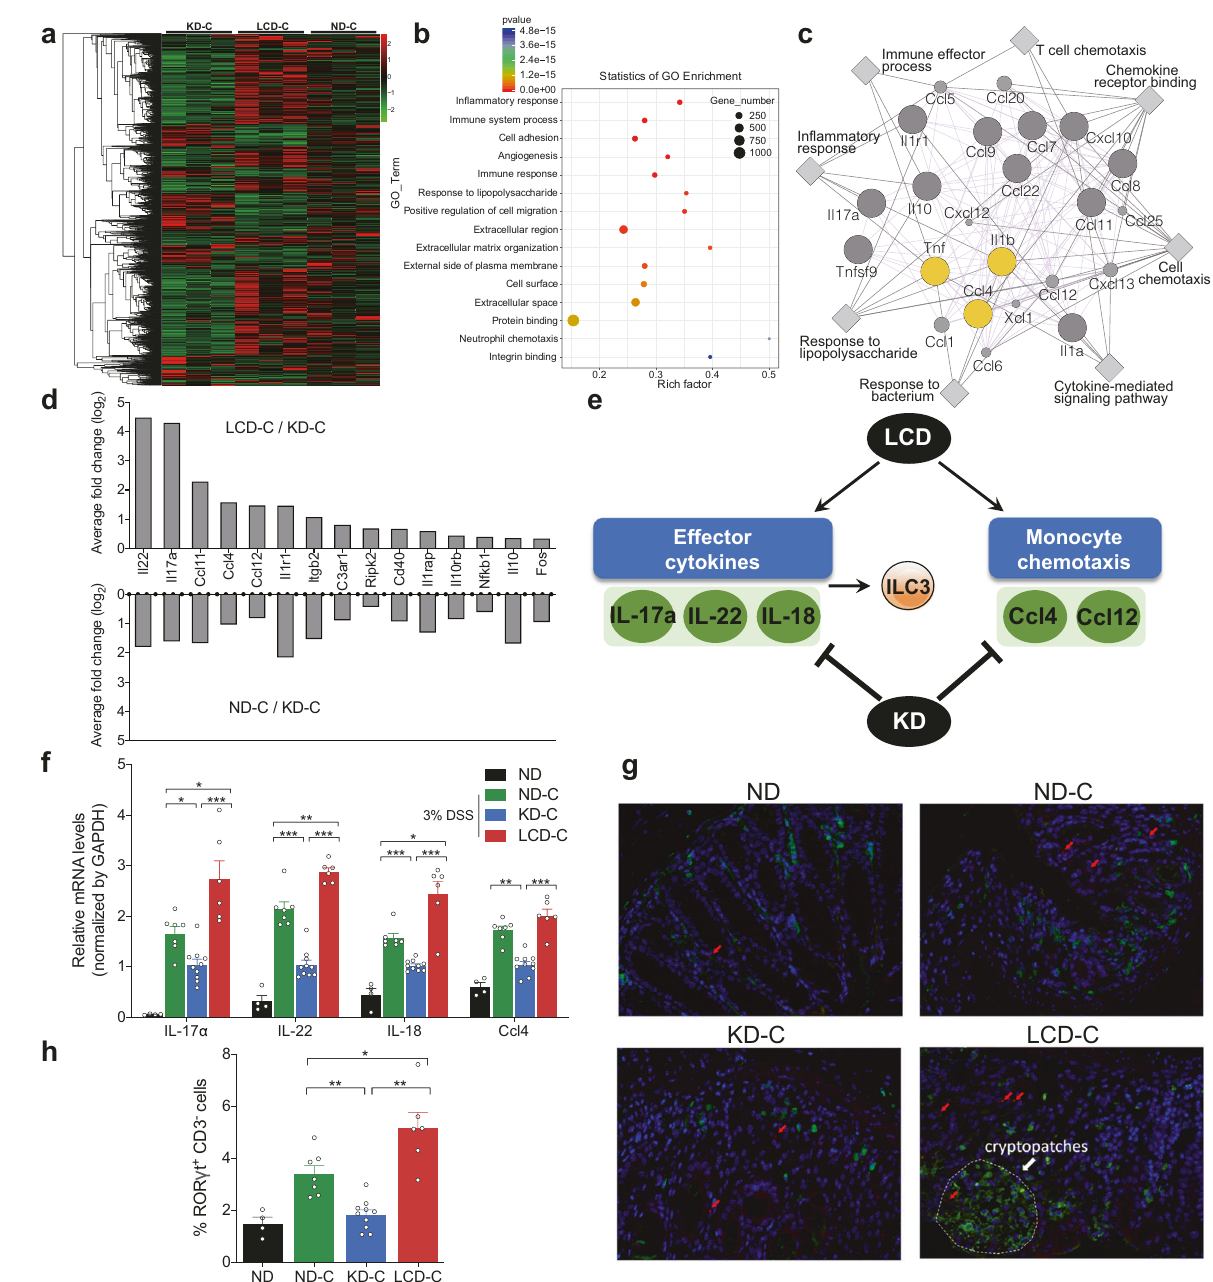
Fig. 4 Effect of KD and LCD on mucosal in fl ammation and immunity in mice with colitis. a Heatmap of 1643 differentially expressed genes among three groups: KD-C (DSS-induced colitis mice fed with KD, n = 3), LCD-C (DSS-induced colitis mice fed with LCD, n = 3), ND-C (DSS- induced colitis mice fed with ND, n = 3). b Gene ontology (GO) functional analysis shows the top 15 biological functions that are enriched in the signi fi cantly expressed genes. c Cytoscape software predicts the interaction between top 20 genes selected according to their corrected p -values and fold change values. d Signi fi cant upregulated expression of 15 transcripts in LCD-C, KD-C, ND-C groups detected by mouse in fl ammatory response and autoimmunity PCR arrays. e Systematic diagram of major in fl ammatory pathways and immune cells potentially regulated by the 15 upregulated genes. f Quantitative RT-PCR con fi rming altered IL-17 α , IL-18, IL-22, and Ccl4 expression. g Representative immuno fl uorescence images of ROR γ t + CD3 − ILC3 cells in colon tissues (original magni fi cation ×400). Green: positive staining of ROR γ t; Red arrows: positive staining of CD3. h Percentage of ROR γ t + CD3 − ILC3 cells in colonic sections. * p < 0.05; ** p < 0.01; *** p < 0.001. (KD-C, n = 10; LCD-C, n = 6; ND-C, n = 7; ND, n = 4). Results are expressed as mean ± SEM ( f, h ). KD ketogenic diet, LCD low-carbohydrate diet, ND normal diet, DSS dextran sulfate sodium, ILC3 group 3 innate lymphoid cell community, while those from KD and LCD microbiota accounted including those affected by the KD ( Akkermansia ), LCD ( Oscilli- for 92% and 93%, respectively (Supplementary Table 3). Of the 80 bacter ), and ND ( Alloprevotella and Lactobacillus ) that were still most abundant OTUs in each microbiota type (88% of ND dominant in the FKD, FLCD, and FND groups, respectively (Fig. 7e). microbiota, 94% of KD microbiota, 93% of LCD microbiota), we Detailed analysis revealed that the OTUs successfully transferred veri fi ed that 68 KD OTUs and 72 LCD OTUs were detected in the from ND microbiota accounted for 98.0% of the donor ’ s entire Signal Transduction and Targeted Therapy (2021)